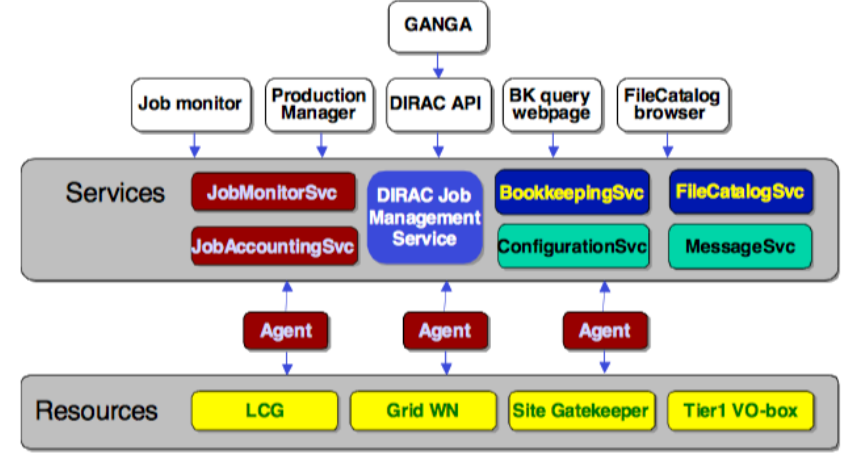
Figure 1. Experiment Control System overview.